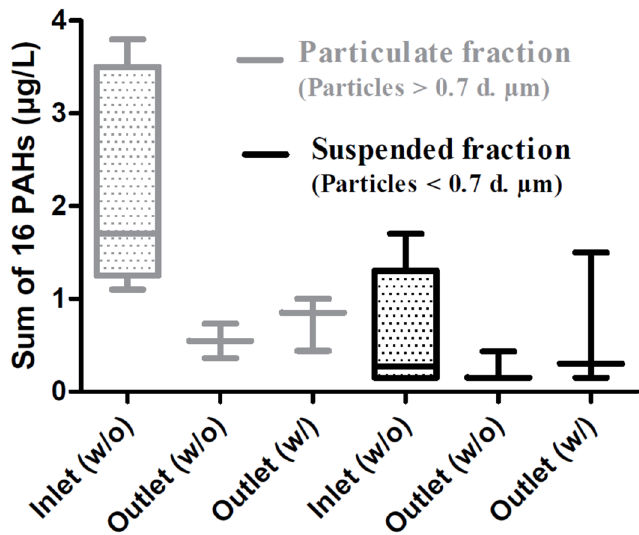
Figure 7. Box-plots of the sum of PAHs found in the inlet and outlet samples, subdivided into the particulate and suspended fraction. The bars indicate the highest and lowest concentration together with themedian, upper and lower quartile of total PAHs measured in the